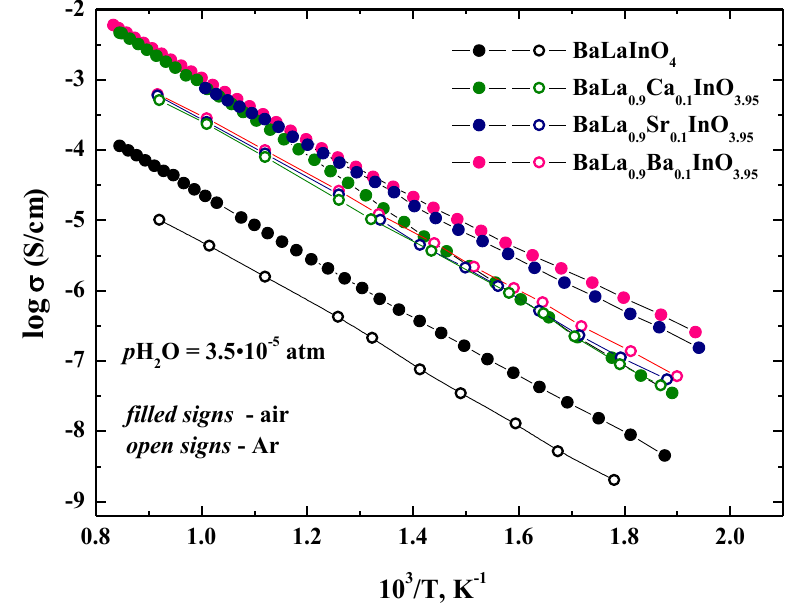
Figure 6. The temperature dependencies of the conductivities of BaLaInO 4 and BaLa 0.9 M 0.1 InO 3.95 (M = Ca 2+ , Sr 2+ , and Ba 2+ ) in dry air (filled signs) and dry Ar (open signs). Thus, the observed increase in the ionic conductivity (Ar atmosphere) for doped phases BaLa 0.9 M 0.1 InO 3.95 in comparison with undoped composition BaLaInO 4 was mainly attributed to the increase of the carrier concentration as a result of the formation of oxygen vacancies during doping.